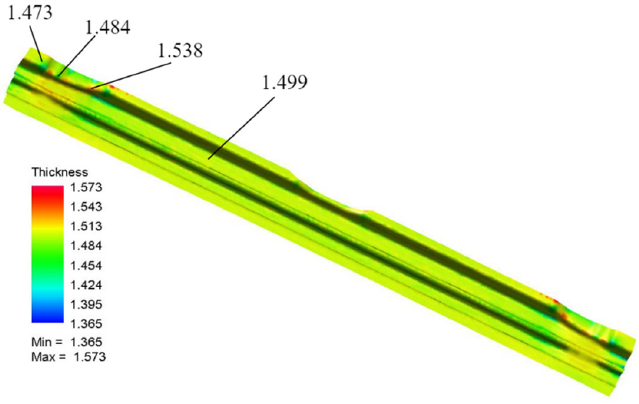
Figure 11. Optimization simulation results.